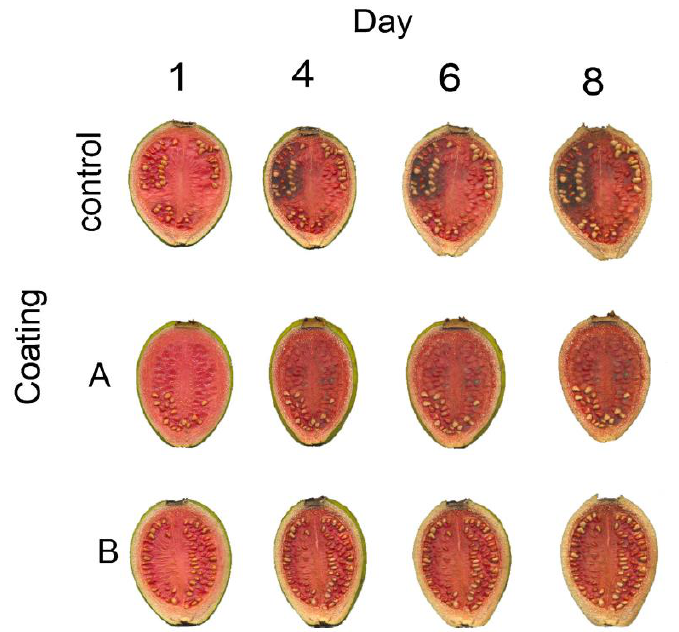
Figure 10. Photographs showing the visual aspects of guavas pericarp as storage at room tempera- ture. The dehydration and change of color are evident for all samples. For control slices, the fungi proliferation is evident after the day 4. Reproduced with permission from [44]. (Copyright 2015 Elsevier).